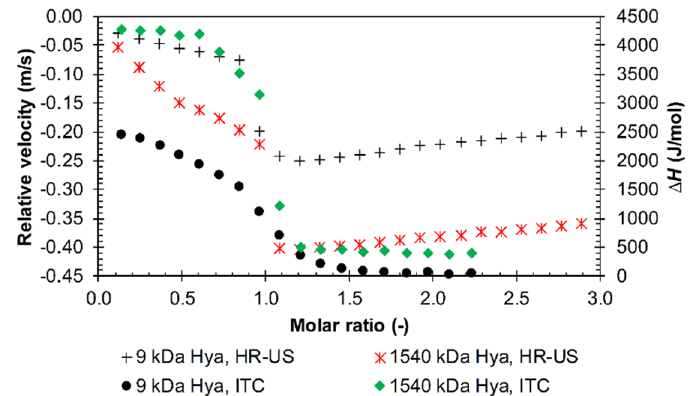
Figure 10. The comparison of HR-US (high-resolution ultrasound spectroscopy) and ITC titration records during the titration of arginine dodecamer in hydrochloride form into 9 and 1540 kDa hyaluronan solutions in water (11.6 MHz, 25